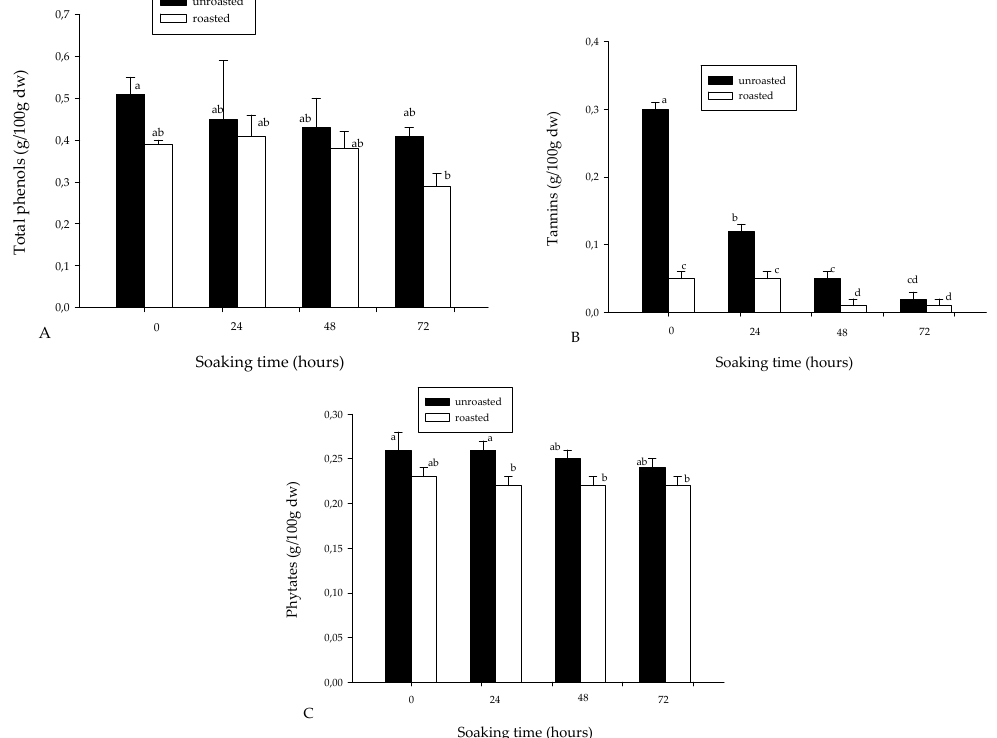
Figure 2. Total ( A ) polyphenol; ( B ) tannin; and ( C ) phytate contents of soybean flour as affected by soaking time and roasting. Bars bearing different letters are significantly different at p < 0.05; n = 3. DW: dry weight.